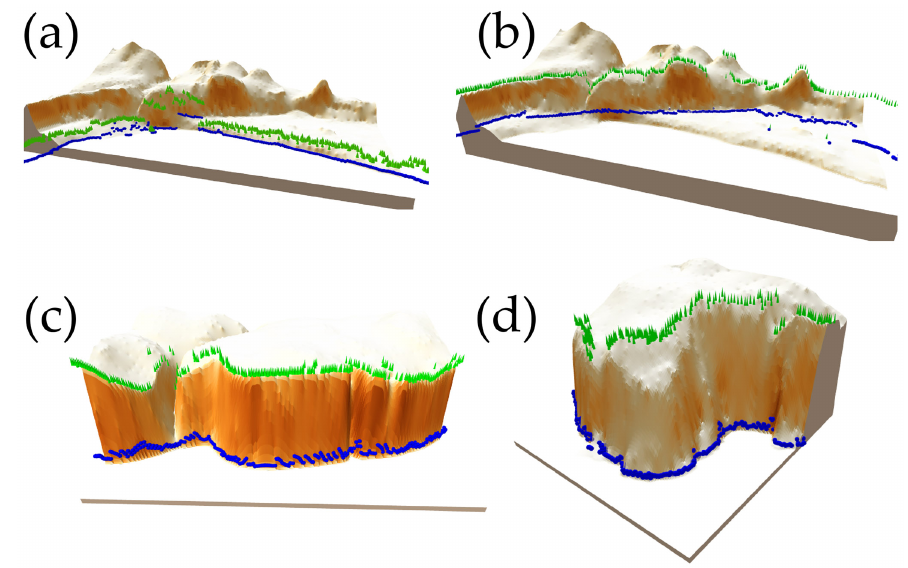
Figure 17. Automatically delineated cliff top and toe locations (green cone and blue spheres) over the DEM for the DG and FH sites; (a) results using current still-water level to delineate the coastline for the DG site; (b) results using a still-water level 6m above current level to delineate the Holocene coastline for the DG site; (c) and (d) results using default model set-up for FH1 and FH2, respectively. DEM colours represent slope (darker colours represent higher slopes). The vertical dimension has been exaggerated 10